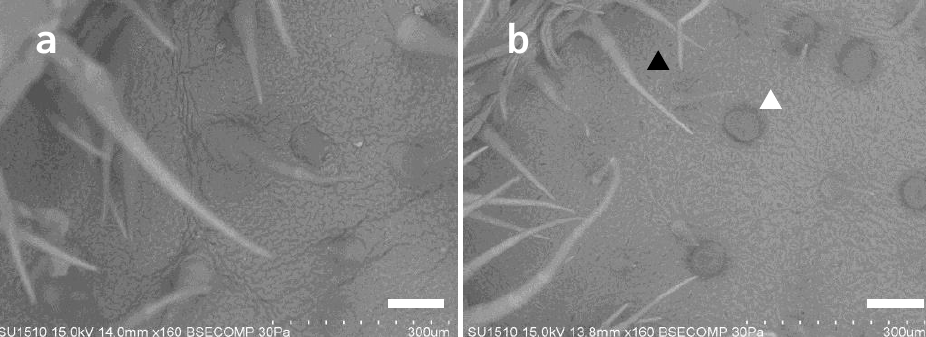
and glandular (white triangle) trichomes on the yacón leaf surface (×160). ( a ) adaxial; ( b ) abaxial (bar: glandular (white triangle) trichomes on the yac ó n leaf surface ( × 160). ( a ) adaxial; ( b ) abaxial (bar: 100 µ